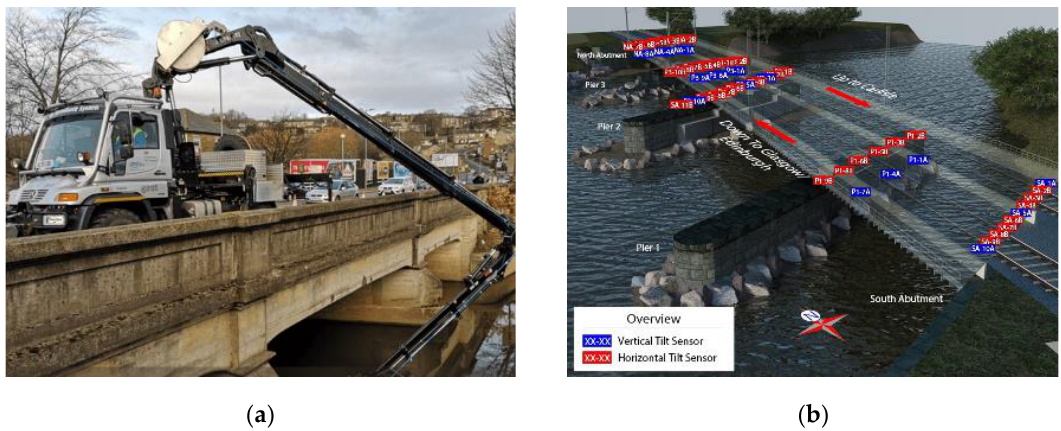
Figure 2. ( a ) BridgeCat technology for bridge inspection [40]; ( b ) Layout of the Structural Health Monitoring (SHM) system installed at the Lamington viaduct (courtesy of Network Rail).